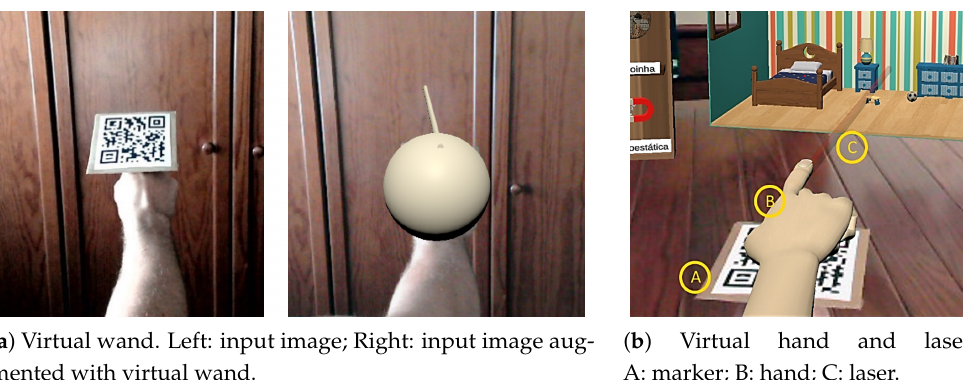
Figure 4. Pointing mechanism: early design in ( a ) and final design in ( b